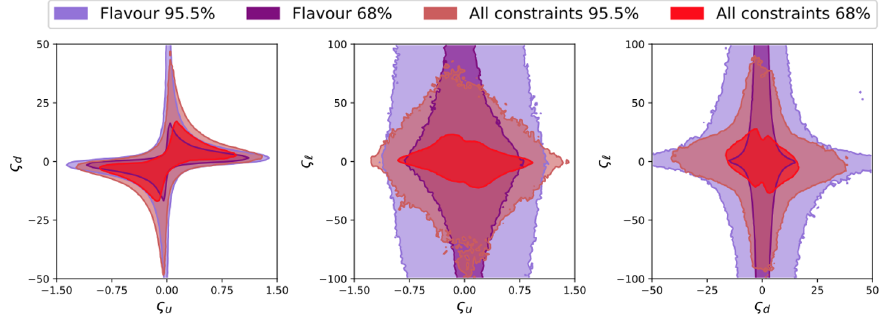
Figure 9. Constraints on the alignment parameters from a fit with only flavour observables (68% probability, violet; 95.5% probability, purple) and from the global fit with the positive branch solution (68% probability, red; 95.5% probability,